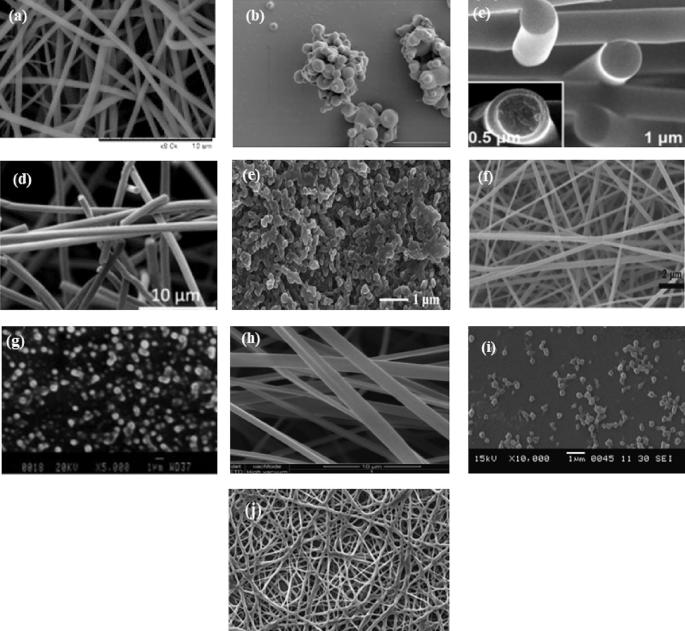
Select photomicrographs of ethylcellulose-based: (a) nanofibre hybrid mat delivery system (adapted from Li et al., 2018a, Li et al., 2018b), (b) nanofiber mesh system (adapted from Huang et al., 2012), (c) layered nanofiber delivery system (adapted from Yu et al., 2015), (d) amorphous monolithic nanofiber (adapted from Illangakoon et al., 2015), (e) nanocomposite (adapted from Taki et al., 2017), (f) composite nanofiber (adapted from Lu et al., 2017), (g) nanoparticles (adapted from Ravikumara and Madhusudhan, 2009), (h) polymeric nanofibers (adapted from Hu et al., 2016), (i) antibiotic nanoparticles (adapted from Pan-In et al., 2014) and (j) antibiotic nanocomposite (adapted from Djerafi et al., 2017).